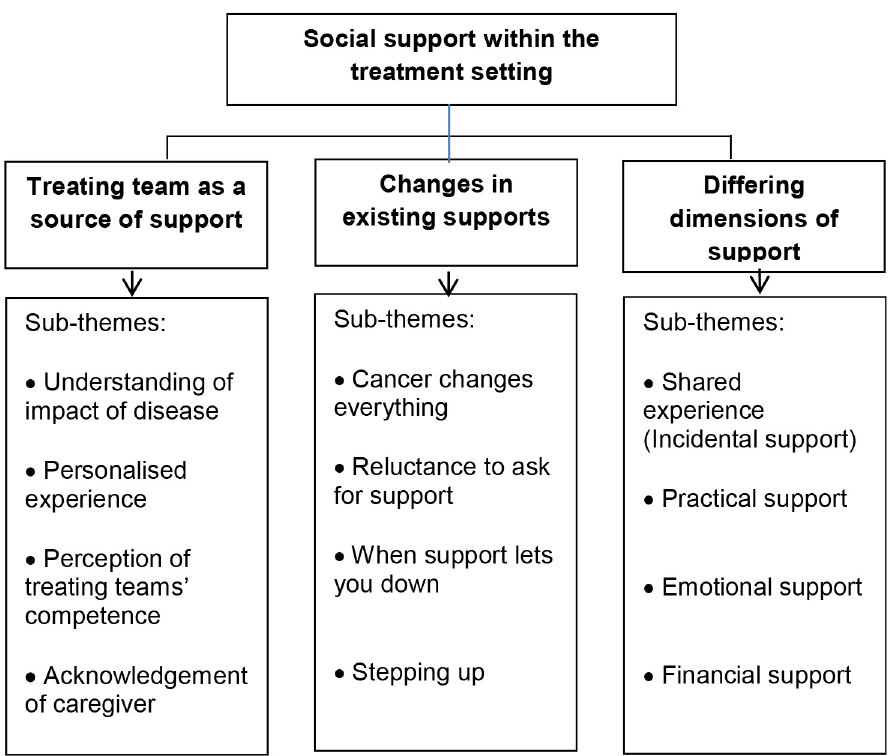
Fig 1. Social support themes and their constituent